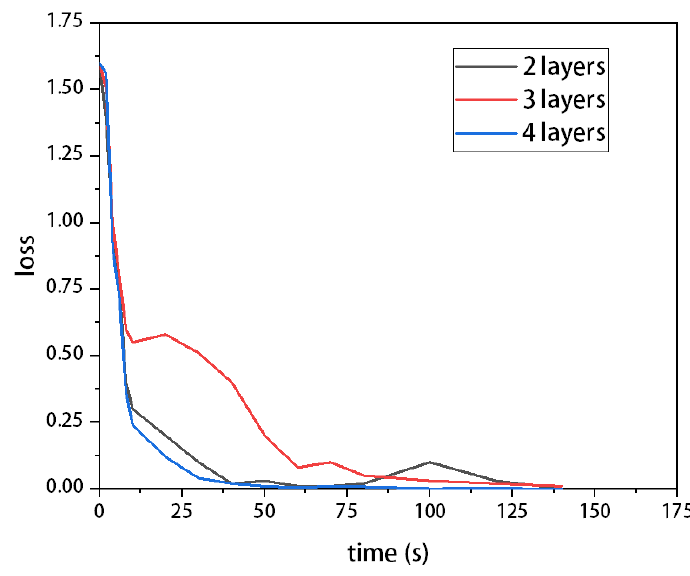
Figure 5. Convergence time in training with different learning rates in pretraining.